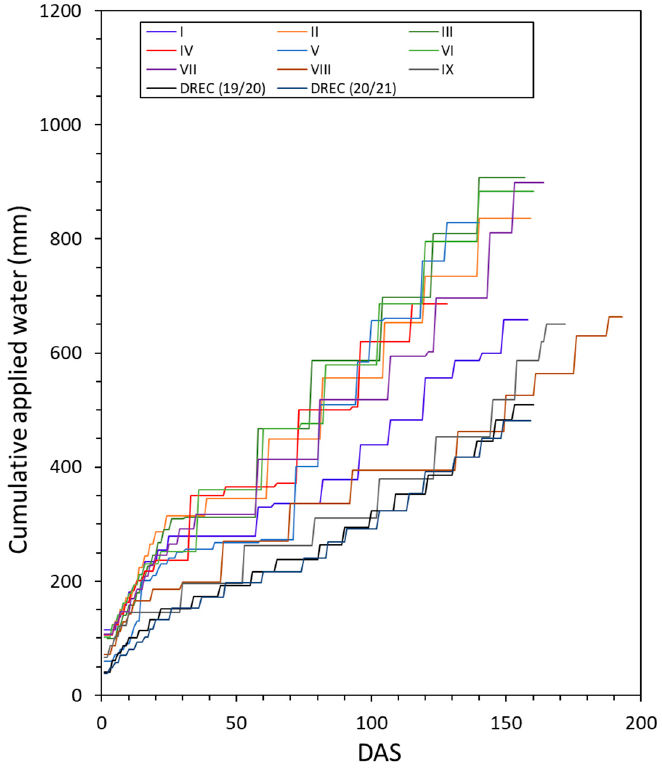
Figure 4. Cumulative applied water (irrigation + rainfall) over the growing season at the experi- experimental sites. mental sites.